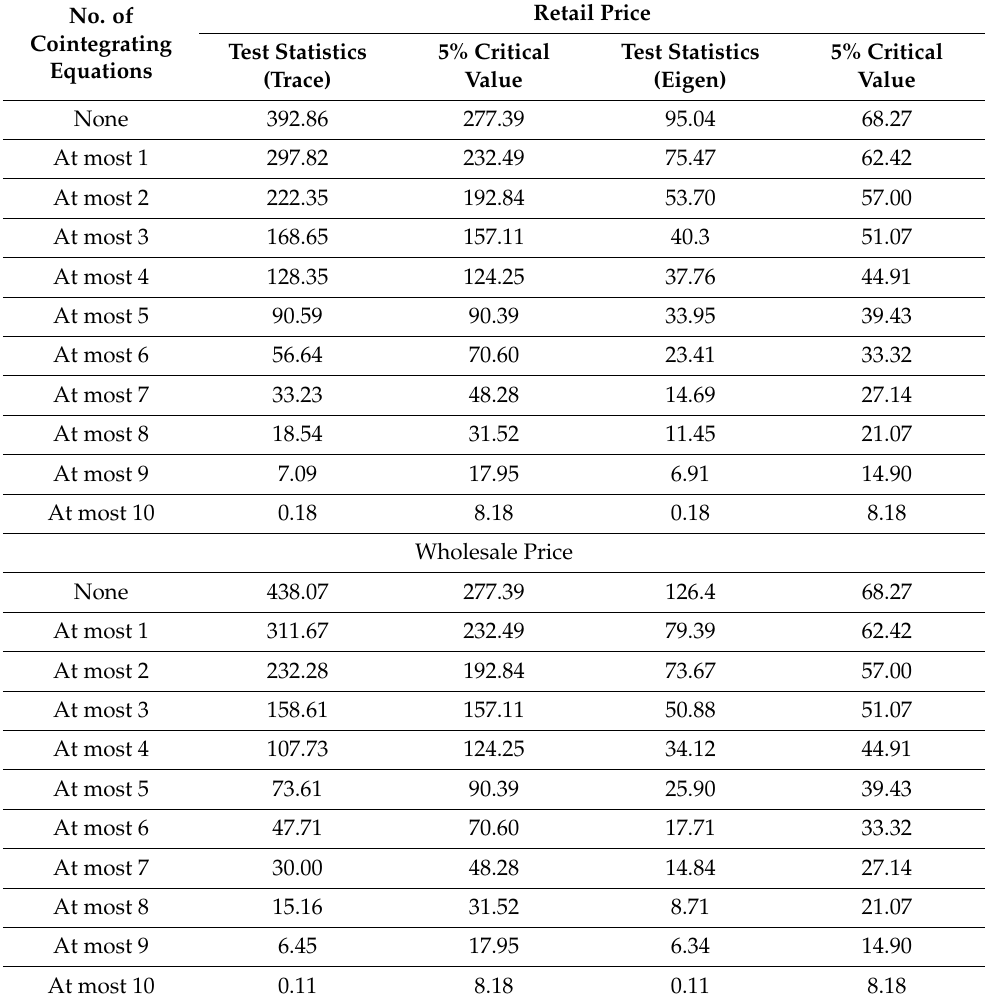
Table 3. Cointegration among the retail and wholesale prices of wheat.